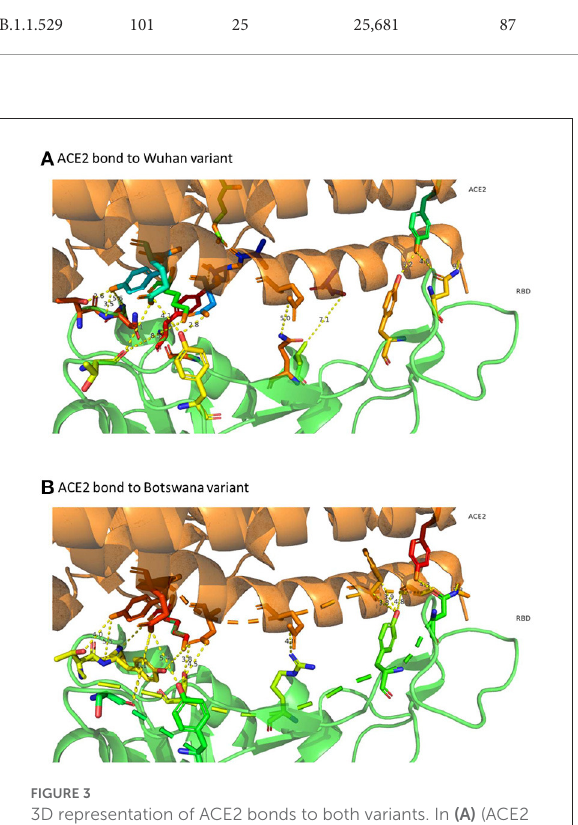
FIGURE3 3D representation of ACE2 bonds to both variants. In (A) (ACE2 link to the Wuhan variant) it can be confirmed that the links are more numerous and with less distance than those that appear in (B) (ACE2 bond to Botswana variant). The yellow dashed line represents the distance between residues SARS-CoV-2 spike proteins and human ACE2 protein.